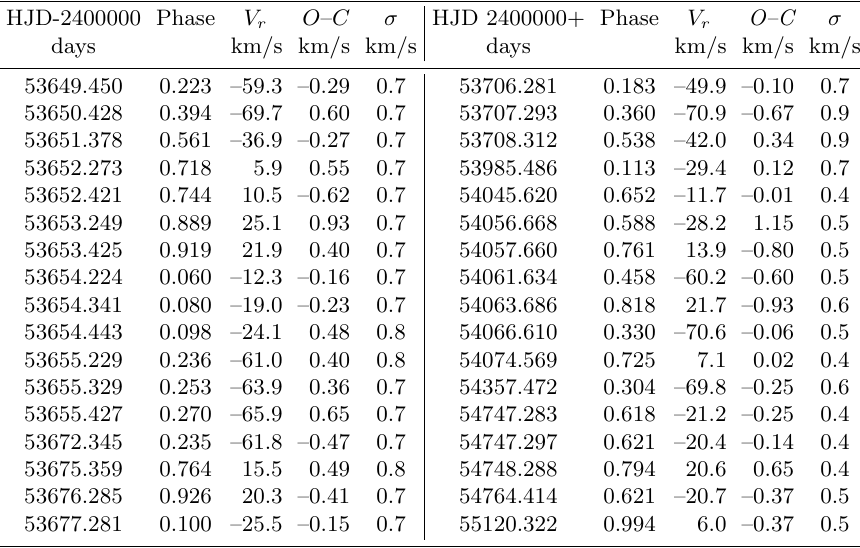
Table 1. Radial velocity measurements.